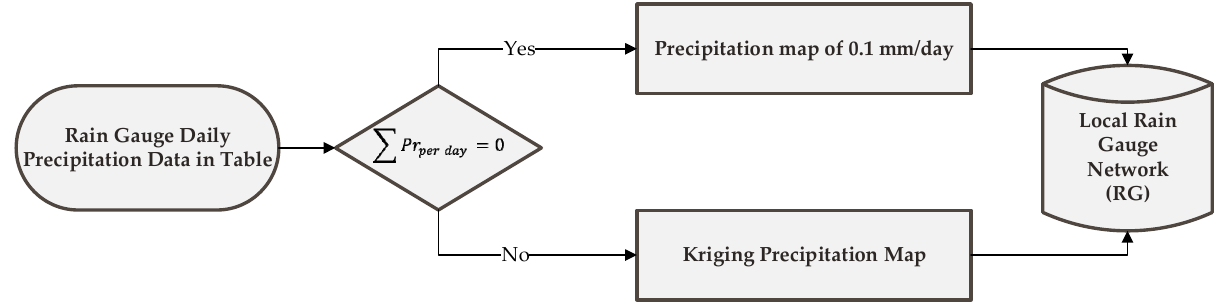
Figure 4. Flow chart process for the generation of a local rain gauge network.